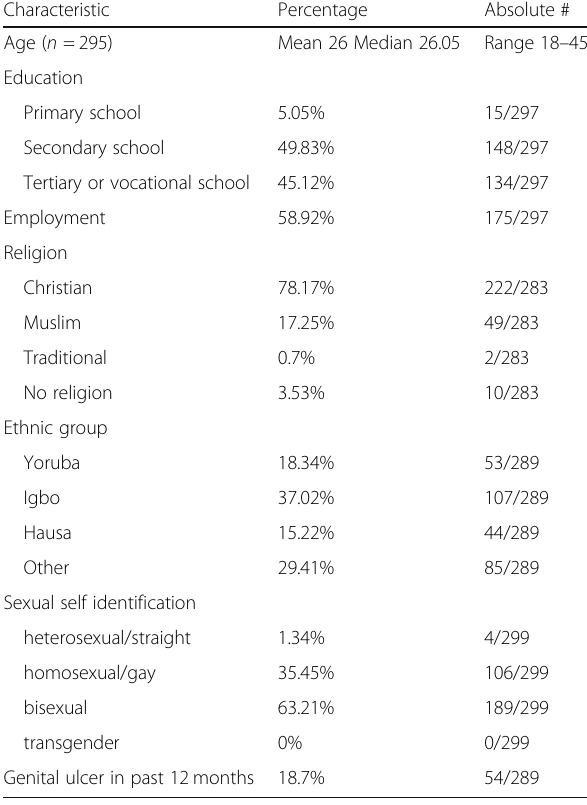
Table 1 Socio-demographic Characteristics of MSM in Abuja Characteristic